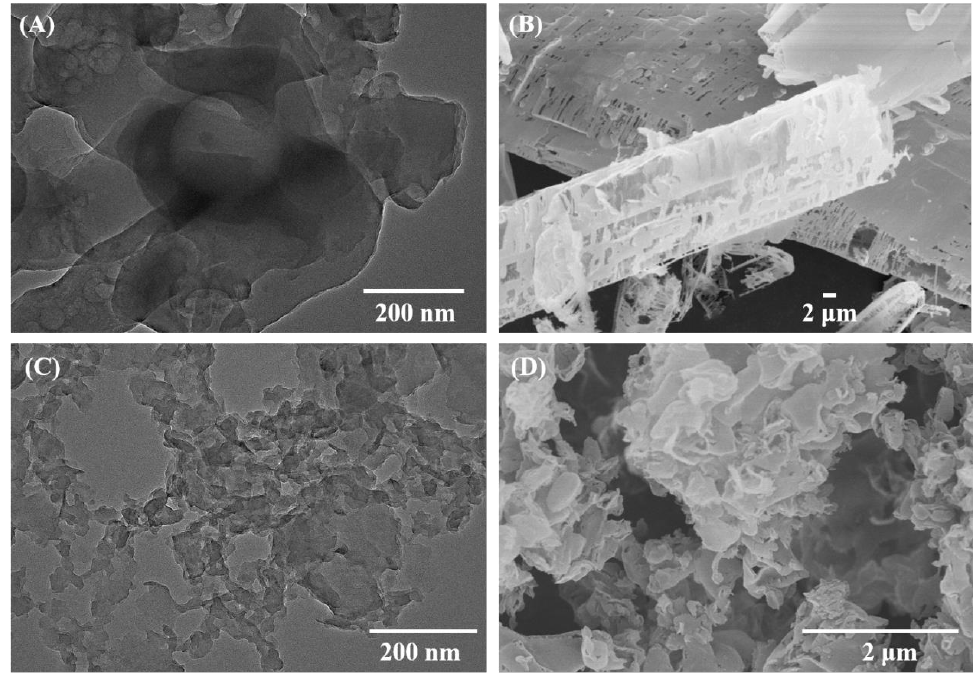
Figure 5. ( A ) HRTEM; ( B ) SEM images of BP-CN-1; ( C ) TEM; and ( D ) SEM images of